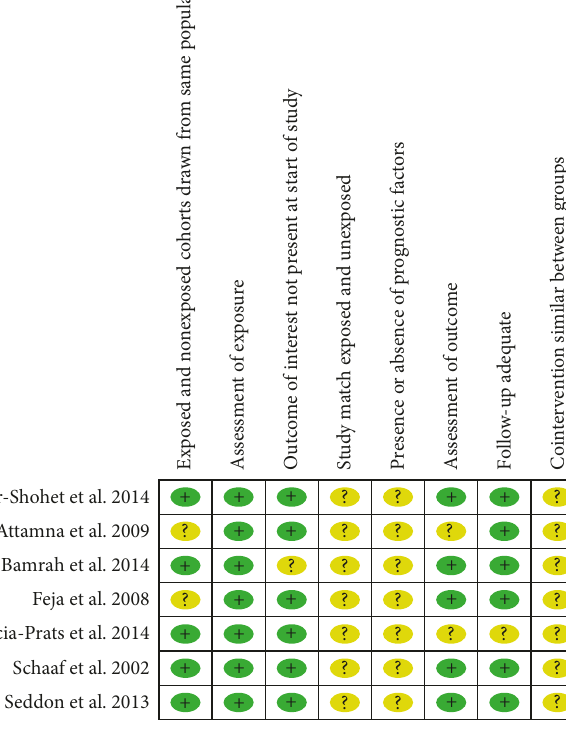
Figure 3: Summary of risk of bias assessment of the seven included